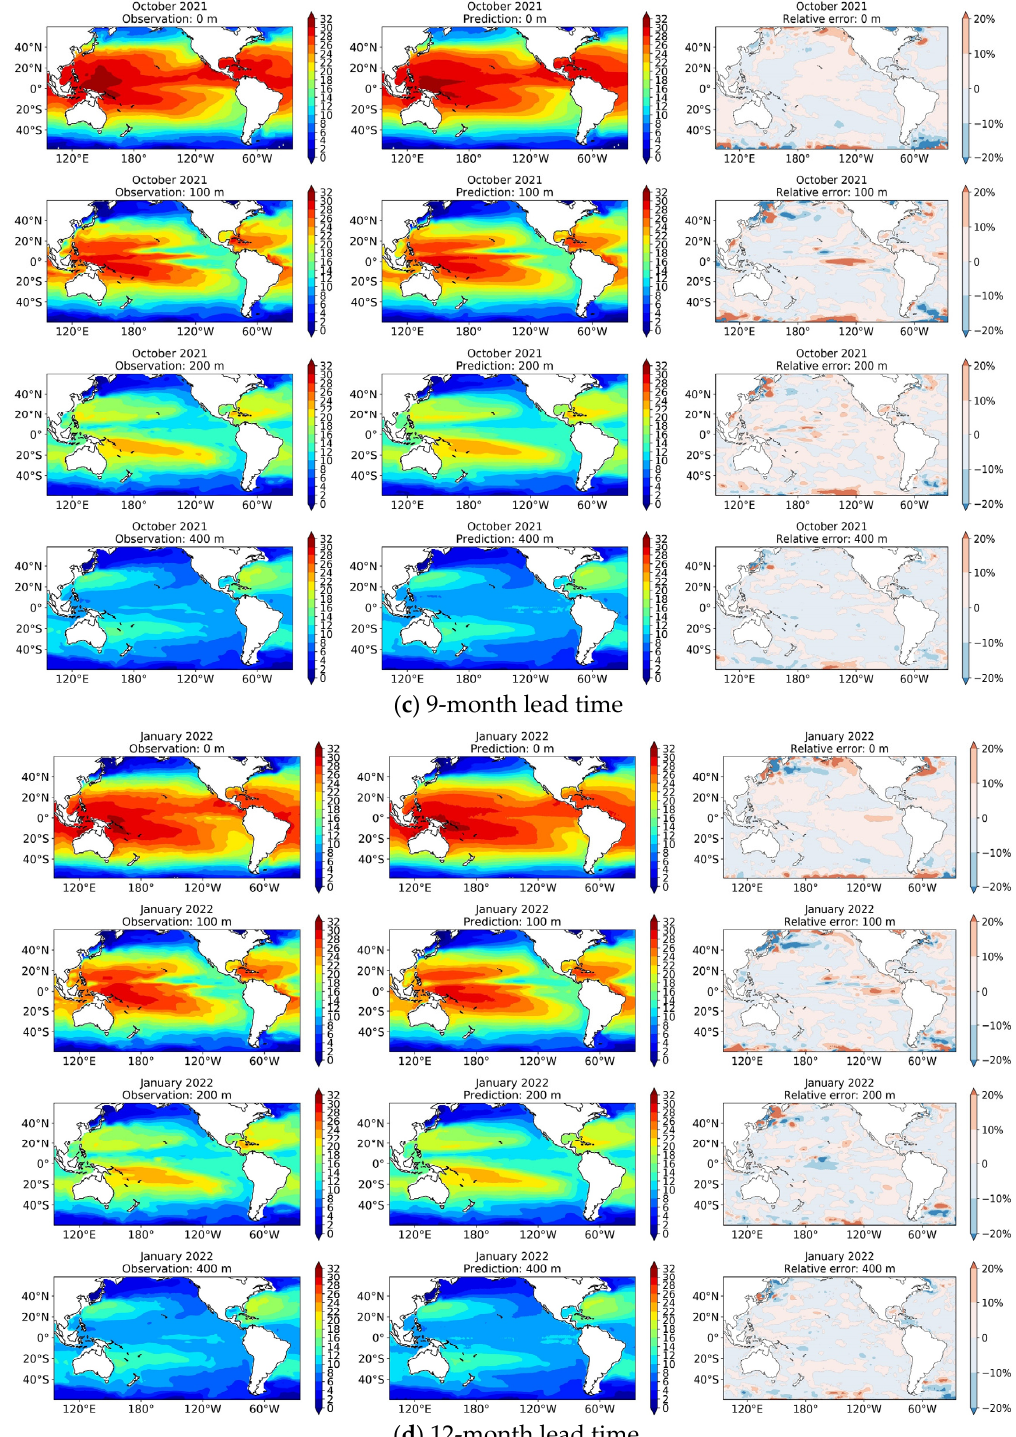
Figure 8. A prediction case starting from January 2021 for lead times of 3 ( a ), 6 ( b ), 9 ( c ), and 12 ( d ) months. In each subfigure, from left to right are the observations, prediction results, and maps of the relative error between them, and from top to bottom, subfigures correspond to depth levels of 0, 100, 200, and 400 m.